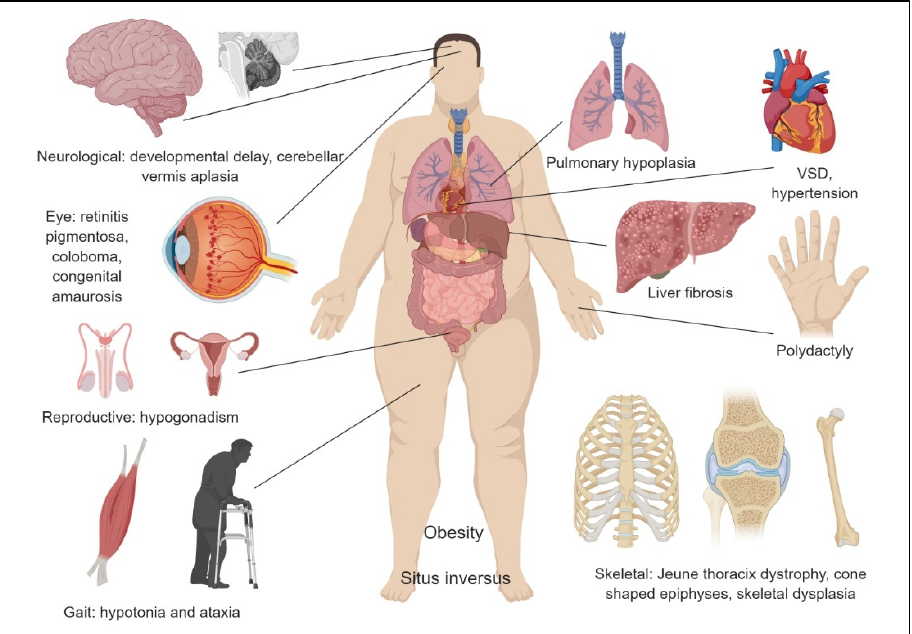
Figure 1. Multi-organ involvement in Nephronophthisis (NPHP) presentation: Schematic showcasing the phenotypic presentations observed in the various forms of NPHP affecting extra-renal sites. Ventricular septal defect (VSD). (Created using BioRender.com).